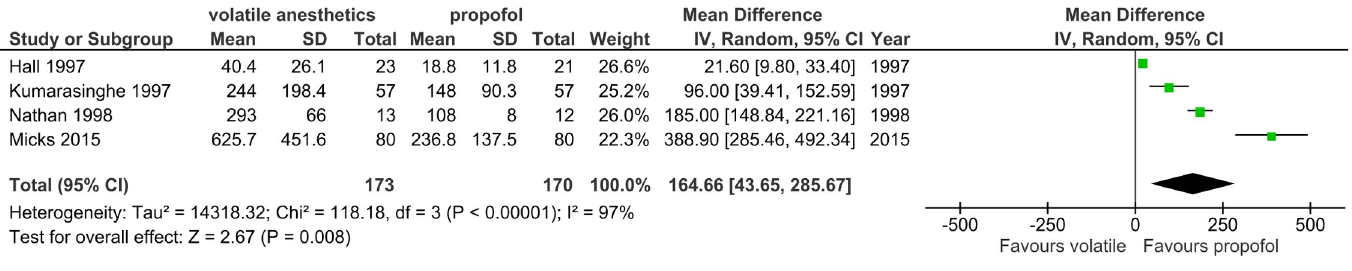
Fig 2. Pooled data evaluating amount of